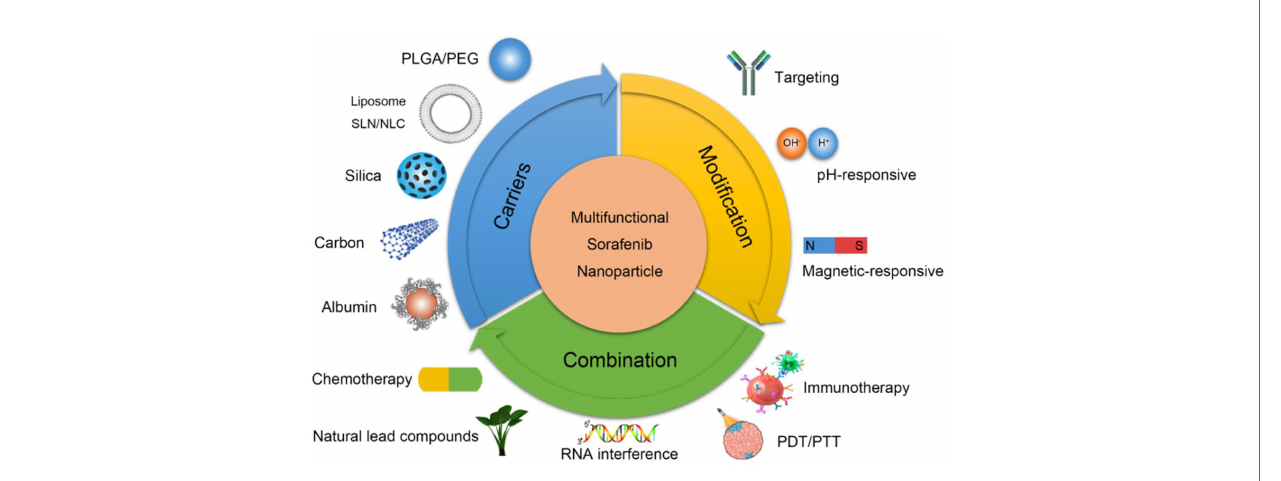
FIGURE 3 | Mechanisms of anti-angiogenic nanoparticles in hepatocellular carcinoma. Improving the biocompatibility of anti-angiogenic agents through different nanocarriers (top left). Increasing the targeting and responsiveness of anti-angiogenic agents through modi fi cation methods (top right). Enhancing curative effect and overcoming resistance through combined with other therapies (bottom) (95). Copyright 2018, Ivyspring International